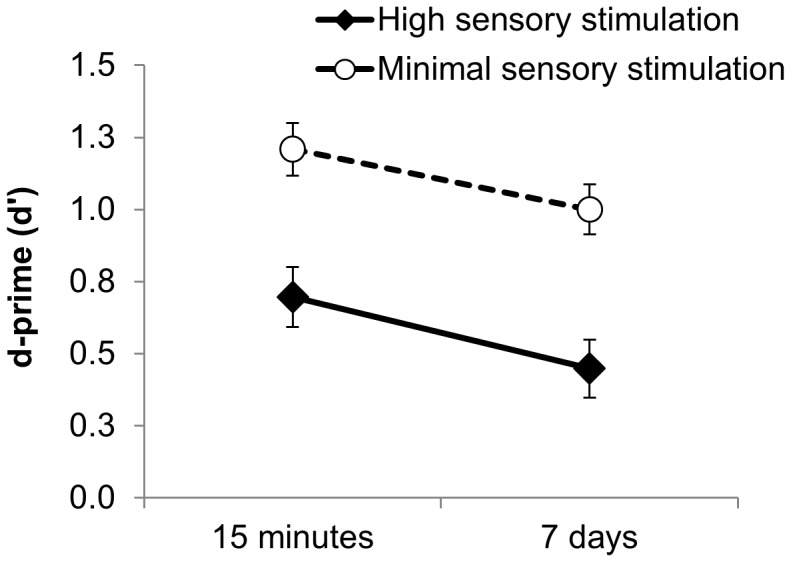
Mean d-prime (d)′ scores for the high sensory and minimal sensory stimulation groups after 15 minutes and after 7 days in Experiment 2.The minimal sensory stimulation group showed superior recognition performance relative to the high sensory stimulation group in a paradigm employing non-recallable stimuli after 15 minutes, and this benefit was maintained for 7 days. Error bars  =  standard error of the mean.